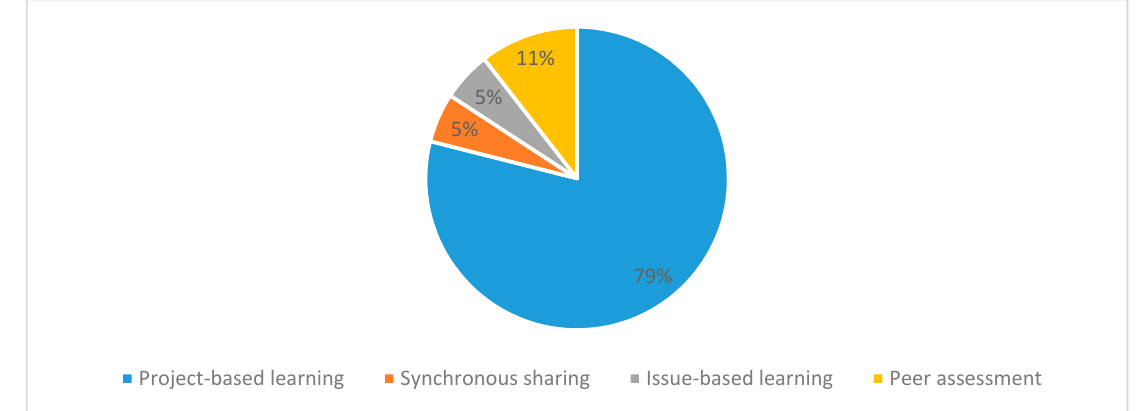
Figure 10. The percentage of learning strategies.